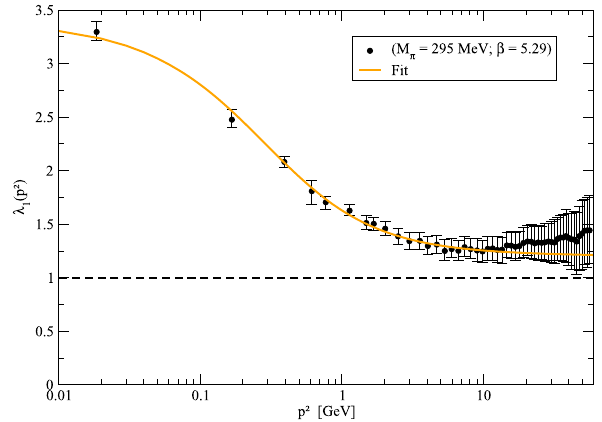
Fig. 1 Lattice data for λ 1 from full QCD simulations [18], in lattice units, and the fit to